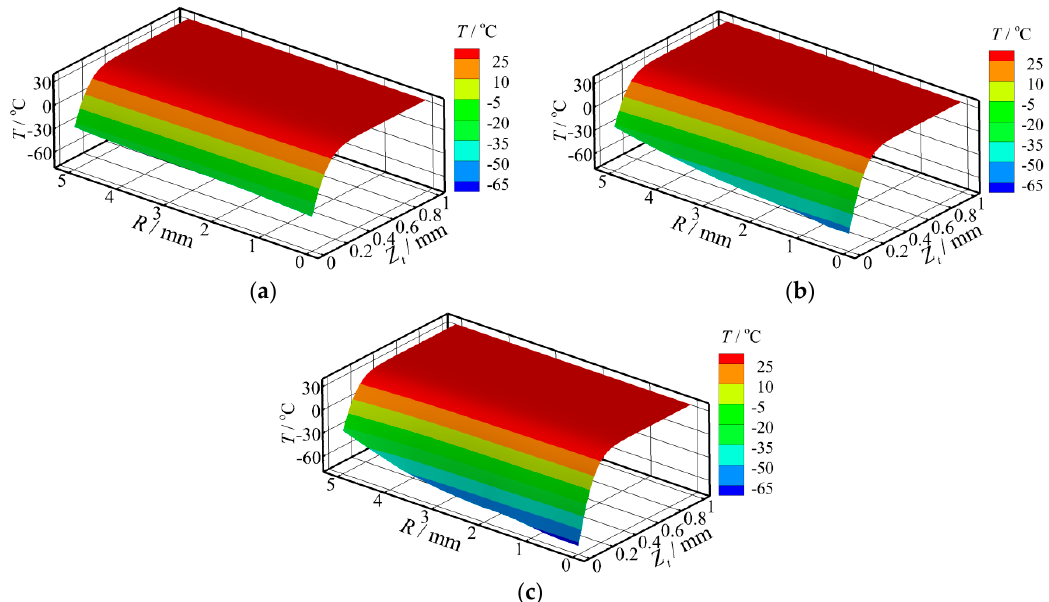
Figure 15. Temperature distributions at central axis section inside skin tissue during CSC under optimum spray distance: ( a ) R134a, ( b ) R404A and ( c ) R32.